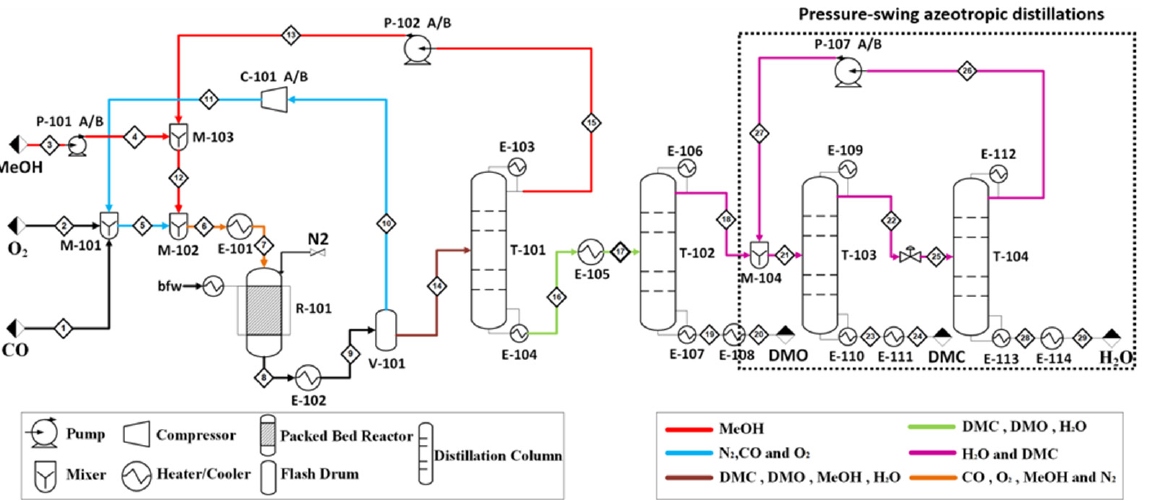
Figure 6. Process flow diagram (PFD) for the production of DMC and DMO via the oxidative car- bonylation of MeOH.